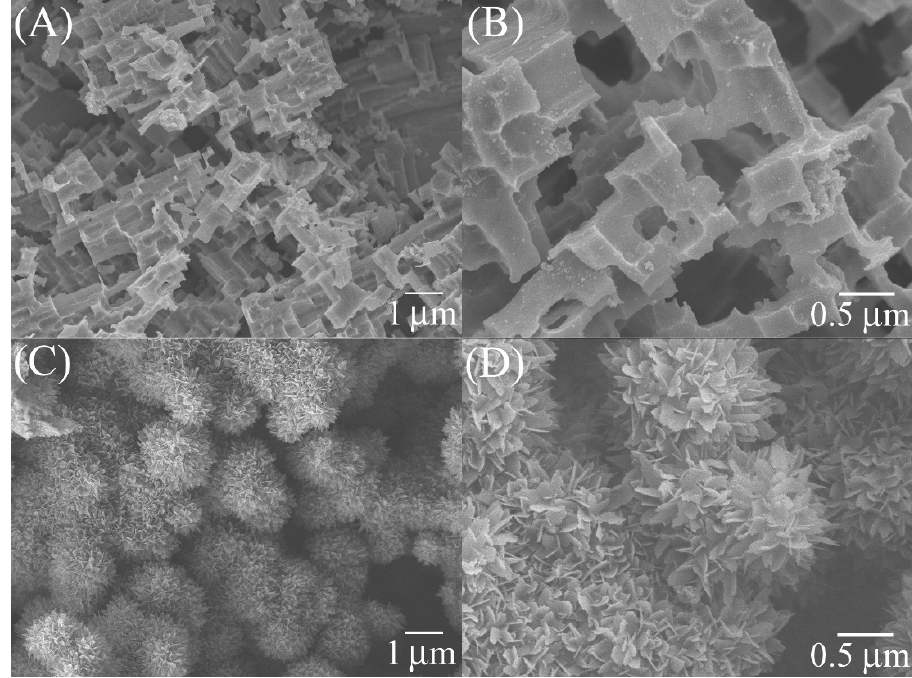
Figure 4. SEM images of the rough Al surfaces prepared via ( A , B ) HCl etching and ( C , D ) HCl etching followed by immersion in boiling water.